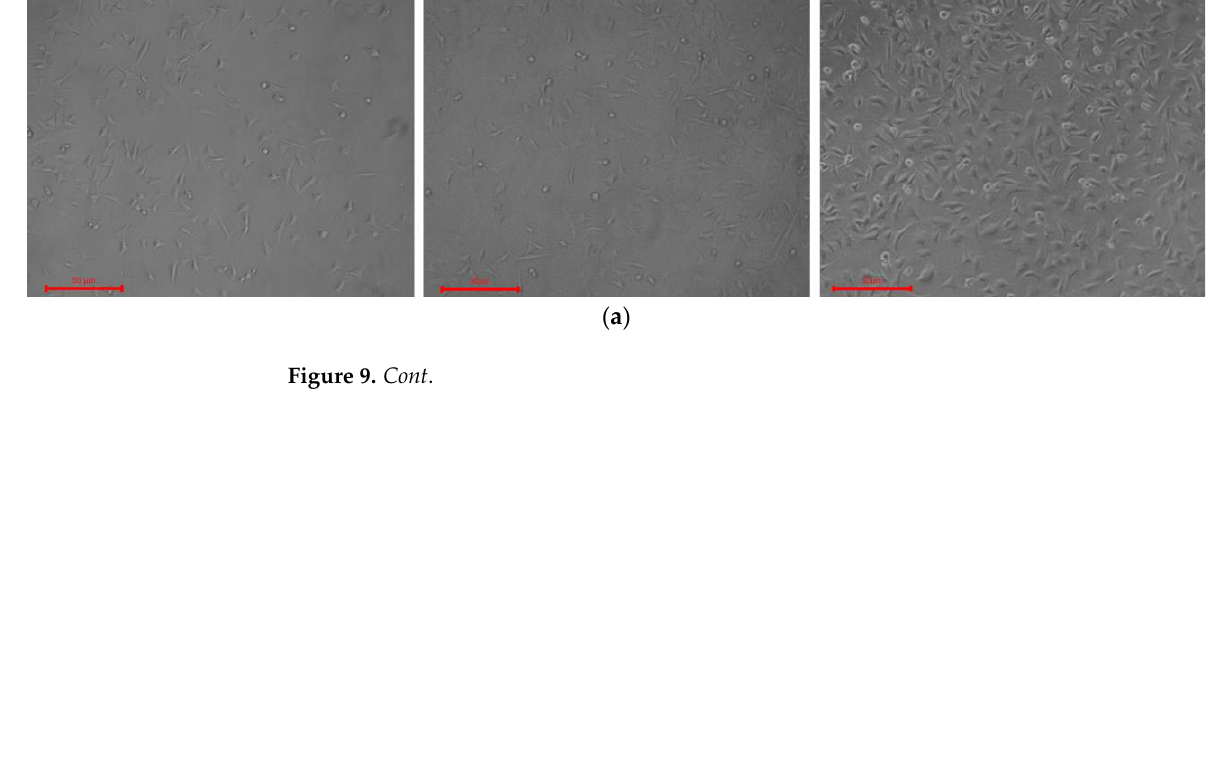
Figure 8. The optical microscopic images of PHB with different hemin content: 0% wt. ( a ), 1% wt. ( b ), 3% wt. ( c ), and 5% wt. ( d ) before fibroblasts seeding BJ-5ta cells. Bar — 50 µm.